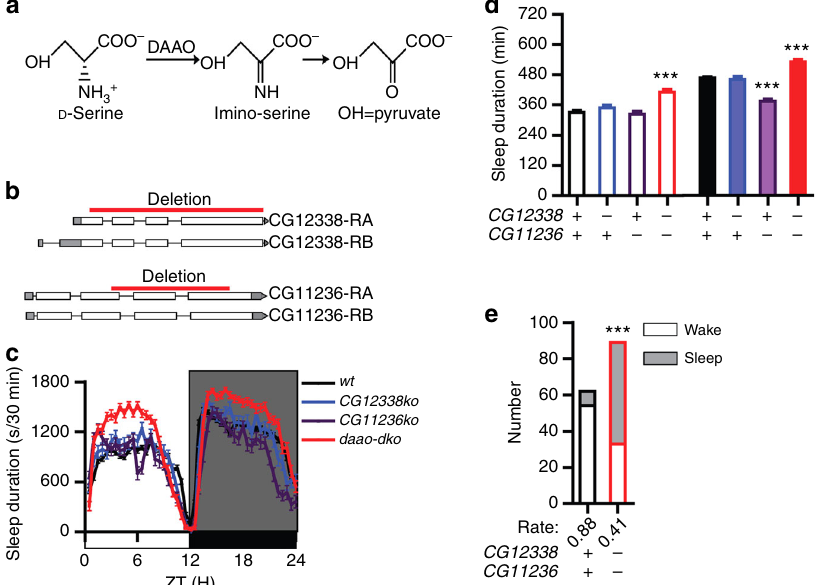
Fig. 3 Sleep phenotype of daao mutants. a A diagram of D-Ser degradation pathway. b Schematic representations of CG12338 and CG11236 genes. The red bars indicate regions deleted in mutant fl ies. For CG12338 , two transcription variants (NM_001299363, NM_136759) generate the same protein of 335aa (NP_001286292, NP_610603) and most of the coding region except the fi rst 97 base pairs (bp) was deleted in the CG12338 knock-out ( cg12338ko ) fl ies. For CG11236 , two transcription variants (NM_135231, NM_001258985) generate two proteins of 341aa (NP_609075) and 338aa (NP_001245914), respectively. CG11236 knock-out ( cg11236ko ) contained the fi rst 94aa because of deletion of 284 bp to 889 bp (NM_135231) or 284 bp to 880 bp (NM_001258985) from each transcript which resulted in frameshifts. c Sleep pro fi les of cg12338ko (blue) ( n = 42), cg11236ko (magenta) ( n = 46), double knock-out ( daao-dko , red) ( n = 40), and wt (black) ( n = 200) fl ies, plotted in 30 min bins. d Statistical analyses. Both daytime and nighttime sleep durations were signi fi cantly increased in daao-dko fl ies, nighttime sleep duration was signi fi cantly decreased in cg11236ko fl ies. e Arousal rate was signi fi cantly reduced in daao-dko fl ies. Numbers of fl ies were plotted for wt (black) and daao-dko (red) fl ies. *** P < 0.001. Mann – Whitney test was used in ( d ), Fisher ’ s exact test was used in ( e ). Error bars represent s.e.m. Male fl ies were